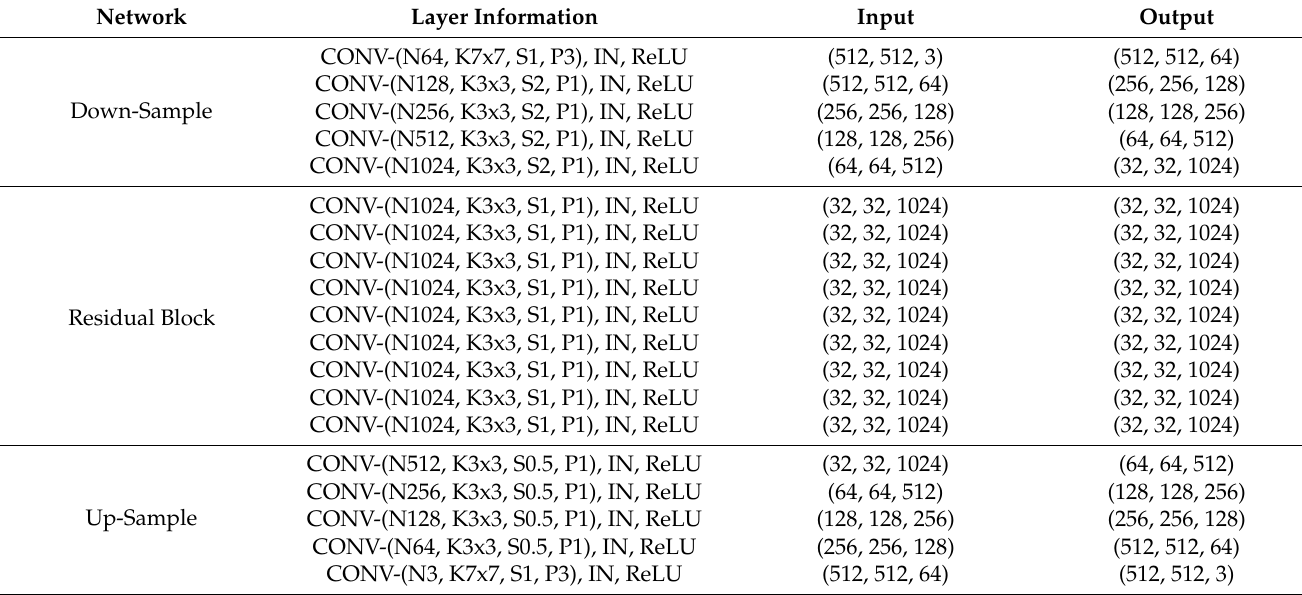
Table 1. The architecture of the generator.